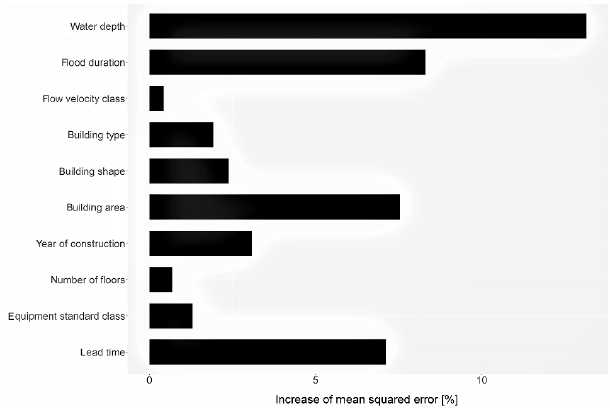
Figure 4. Random forest variable importance for the estimation of building damage in the private household sector ( n = 1610). Impor- tance measure is the mean square